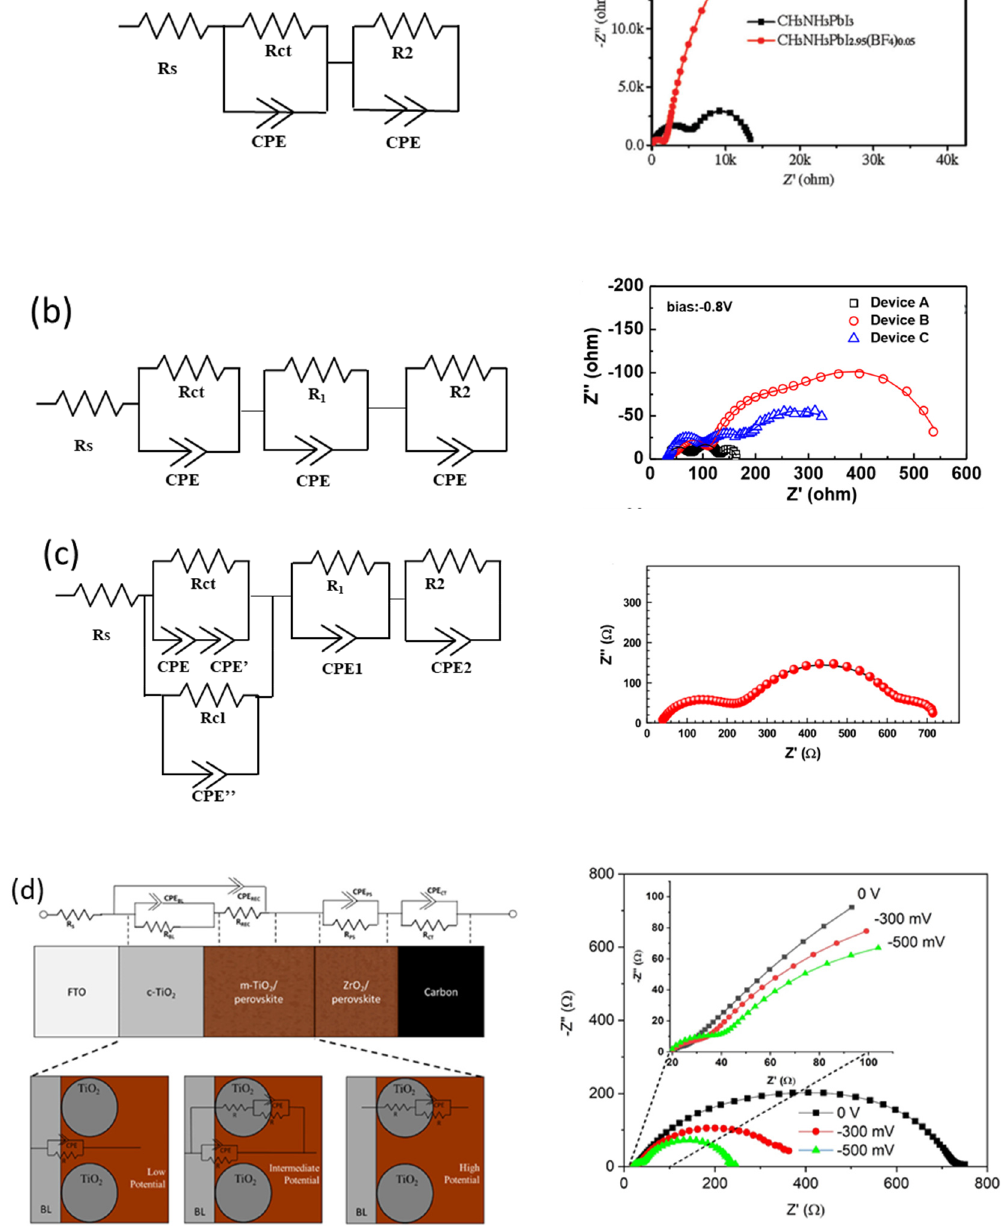
Figure 6. Electrical equivalent circuits for HTM-free perovskite solar cells with their corresponding Nyquist plots: ( a ) 2-RC model. Reproduced with permission from [32]. Wiley-VCH Verlag GmbH & Co. KGaA Weinheim, 2016. ( b ) Nyquist plots of Device A (containing MAPbI3 perovskite), Device B (containing MAPbI2.7Br0.3 perovskite), and Device C (containing MAPbI2.4Br0.6 perovskite), fitted with 3-RC model. Reproduced with permission from [30]. Royal Society of Chemistry, 2016. ( c ) Quadruple mesoscopic layer architecture fitted with 4-RC model. Reproduced with permission from [31], Elsevier, 2015. ( d ) Electric current follows the diagram for m-PSCs under low, intermediate, and high potentials. Reproduced with permission from [67]. Elsevier, 2020.